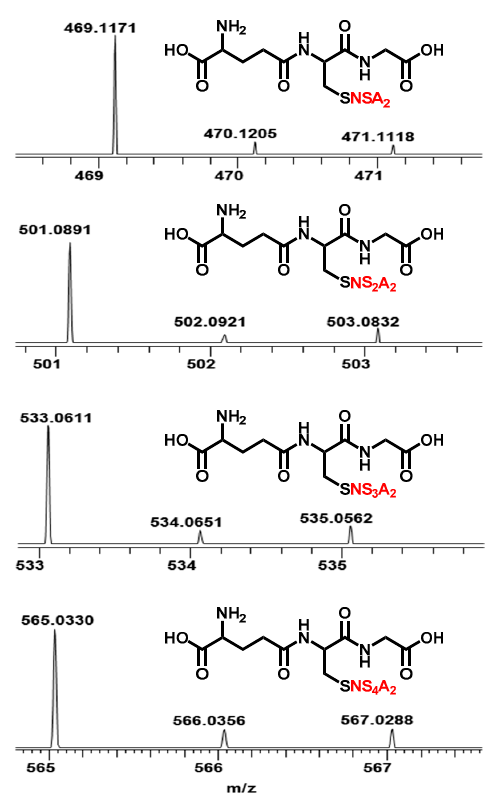
Figure 8. MS of GSS n NA 2 in the reaction GSNO (1 mM) and Na 2 S (1 mM) in the presence of IA (5 mM) in iP buffer, pH 7.